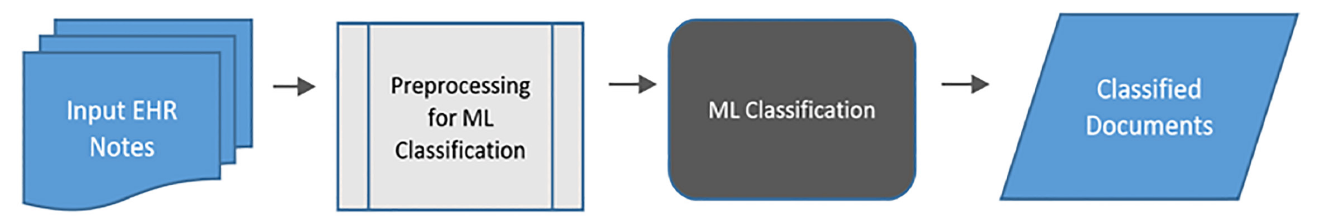
Figure 1. Application pipeline. EHR , electronic health record; ML , machine